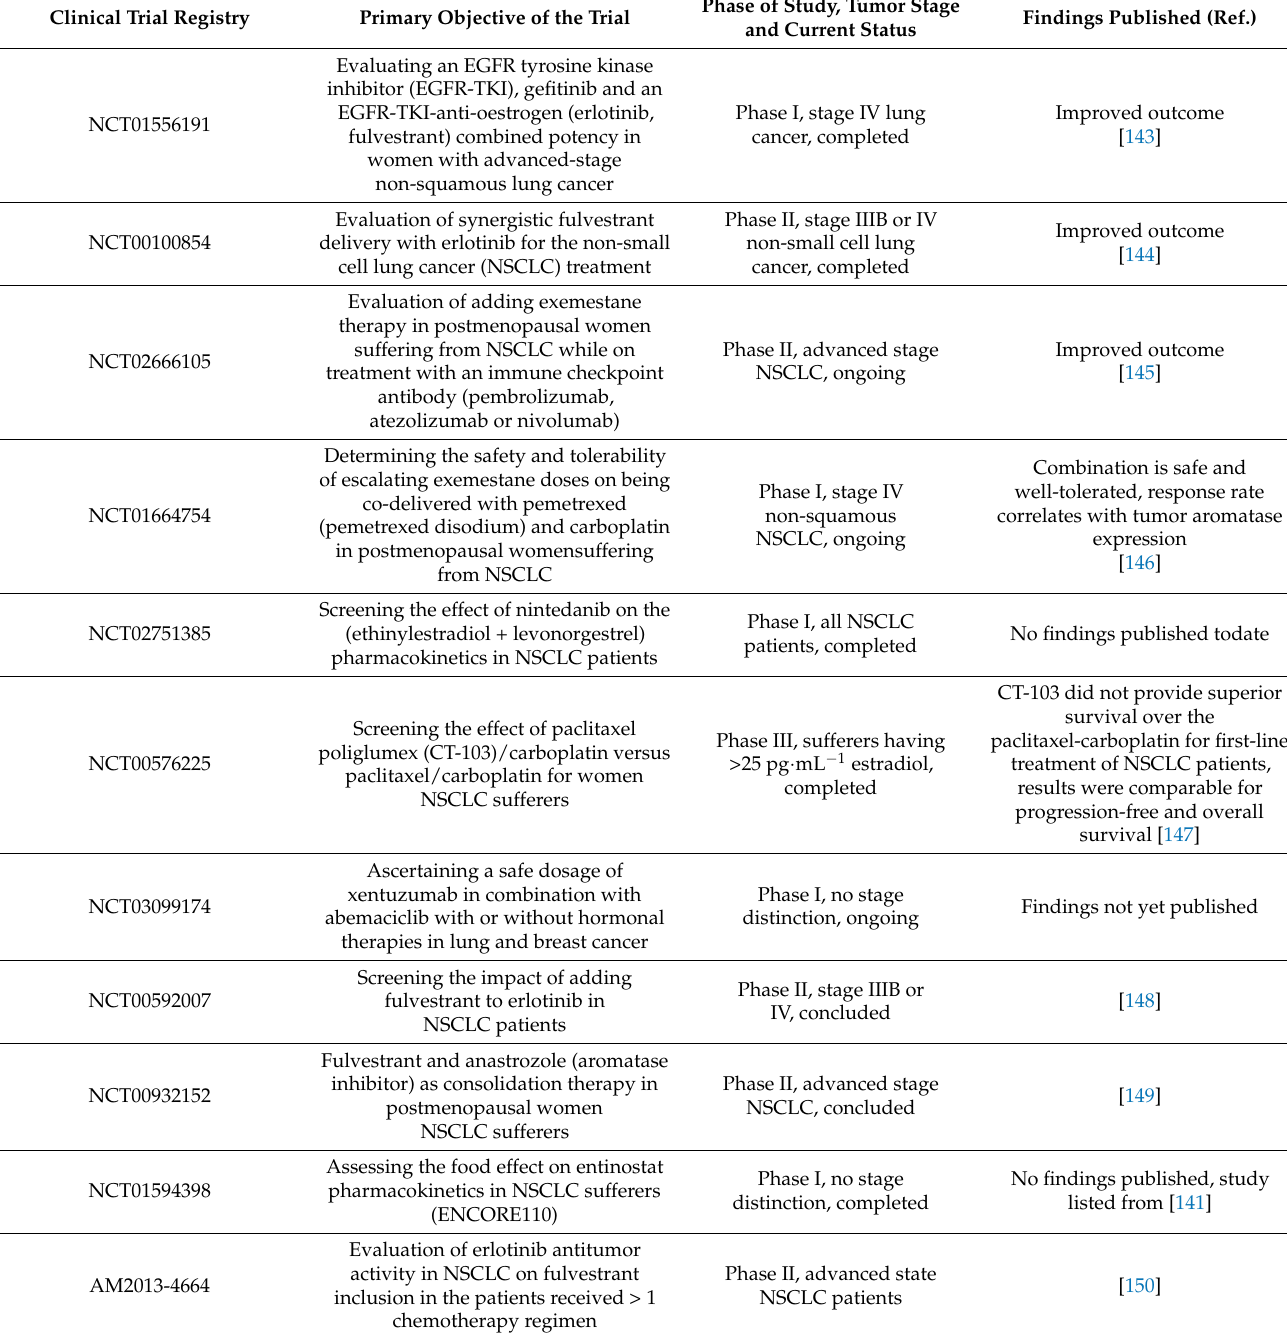
Table 2. Current progress of clinical trials aimed toward using estrogen-expression-targeted non- small cell lung cancer